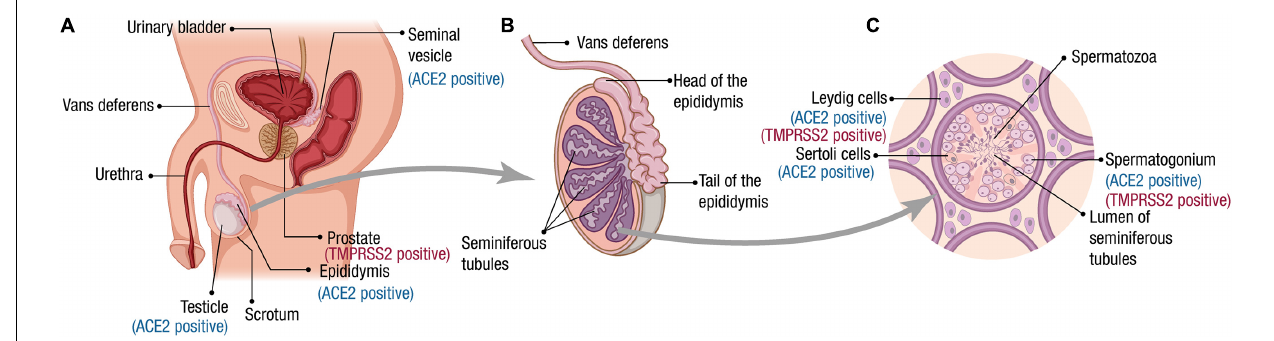
FIGURE 1 | Male reproductive tract, spermatogenesis, and SARS-CoV-2 receptor expression. (A) Scheme of the male reproductive system composition. The organs for which ACE2 and TMPRSS2 expression has been reported at RNA and/or protein level are indicated. (B) The testes are composed mainly by seminiferous tubules (up to 90% of the testis volume). Immotile sperm flow from the lumen of the seminiferous tubules into the epididymis via the rete testis. During the passage through the epididymis to the vas deferens, the spermatozoa mature and acquire their motility. (C) A transverse section of seminiferous tubules is illustrated. The cells for which ACE2 and TMPRSS2 expression has been reported at the RNA and/or protein level are indicated. Spermatogenesis occurs within the seminiferous tubules. Spermatogonia (diploid primordial germ cells) are located near the basal lamina of the seminiferous tubules. When spermatogonia divide by a first mitotic division, they produce diploid primary spermatocytes. Half of these primary spermatocytes will remain near the basal lamina dividing mitotically to allow the production of new spermatozoa during the whole male’s reproductive lifespan. The other half migrate toward the lumen of the seminiferous tubules and undergo meiosis I, generating haploid secondary spermatocytes, which divide through meiosis II to produce haploid spermatids. A final stage called spermiogenesis produces mature sperm cells (spermatozoa) capable of fertilizing an egg. Leydig cells produce the hormone